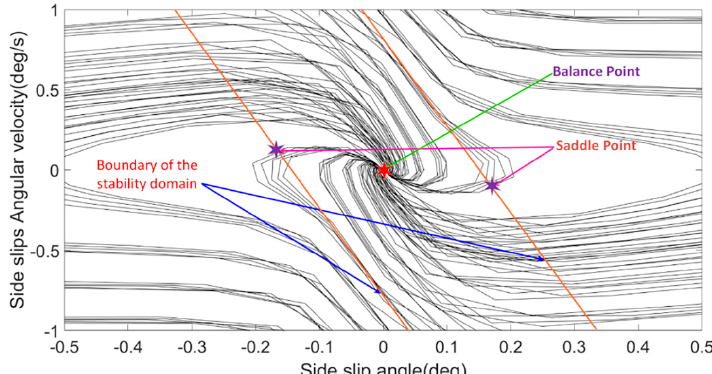
Figure 2. Schematic diagram of the stable domain of the phase plane divided by the bilinear method.